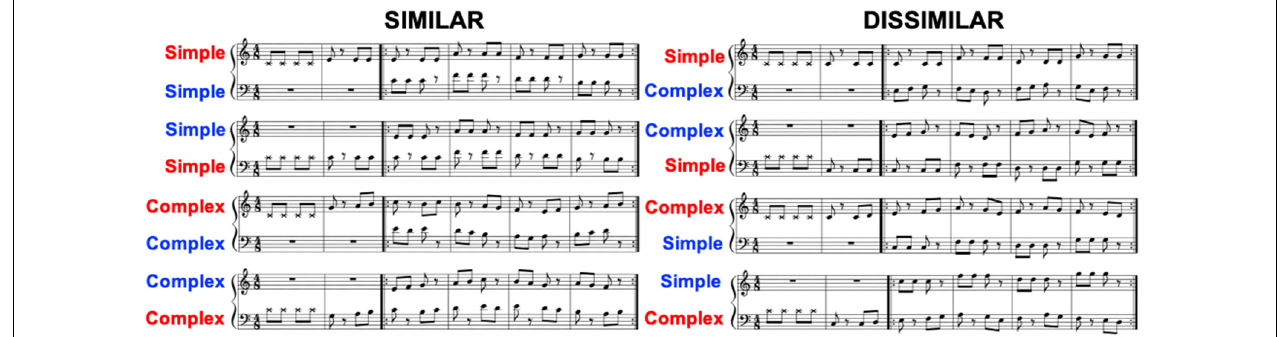
FIGURE 2 | Music scores of eight piano duets composed for this study. Each duet consisted of two parts (e.g., lines) that were either similar or dissimilar , as defined by pitch range and melodic complexity. In similar duets (left panel) the pitch ranges of the two parts overlapped while in dissimilar compositions they did not (right panel). Similar duets also included parts that were either both melodically simple or complex, while dissimilar duets included one of each kind of part. For half of the duets the starting part (red labels) was placed in the top line with the joining part (blue labels) in the bottom. For the other half the line placement was reversed. Pianists had to repeat the four bars of each duet indicated by the repeat signs a total of four times. The metronome count-ins for the starting pianist were added to the starter’s